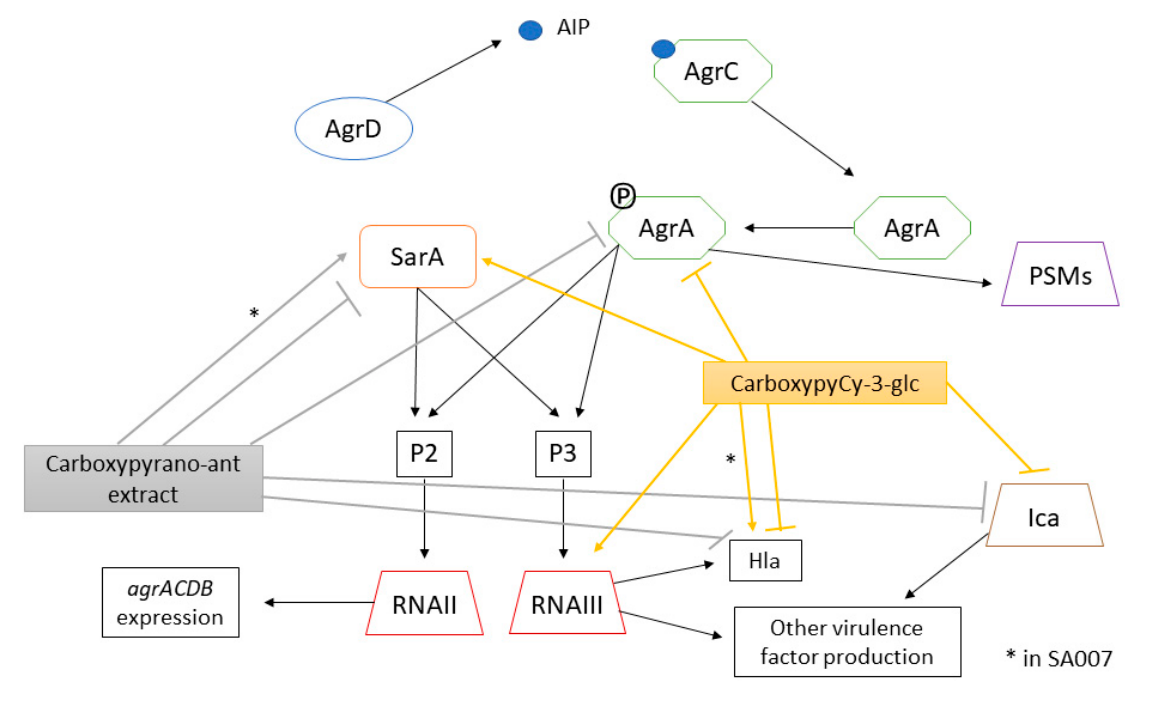
Figure 8. Agr system of S. aureus and overview of the effects of carboxypyrano-ant extract and carboxypyCy-3-glc on the QS system of S. aureus ATCC 29213 and/or SA007 and SA011. (*) points out the opposite effects of the extract or compound on the same gene among the strains.